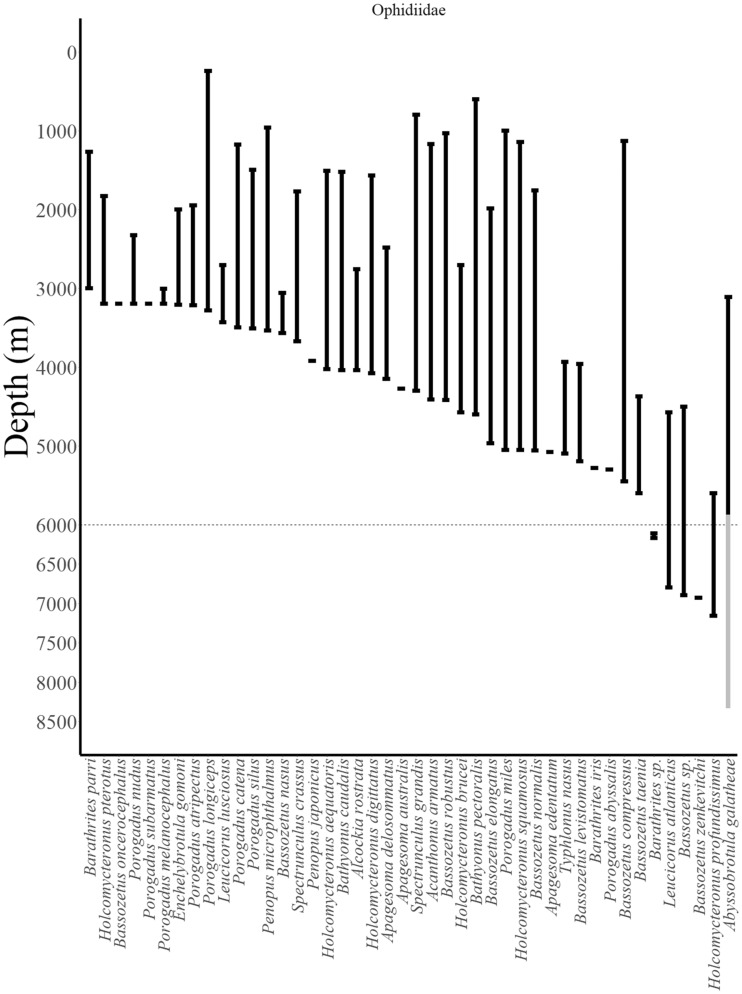
Reported depth distributions of deep-dwelling fishes (collections >3000 m) by family (Ophidiidae). Abyssal–hadal boundary at 6000 m shown as dotted line. Data from FishBase (Froese and Pauly 2014) checked in the primary literature (Nielsen 1977; Andriashev and Stein 1998; Nielsen et al. 1999; Chernova et al. 2004; Chernova 2006; Duhamel and King 2007; Moller and King 2007; Jamieson et al. 2009; Linley et al. 2016, 2017; Gerringer et al. 2017b). Uncertain record from open trawl shown in gray. See Supplementary Note 1 for notes on record verifications.